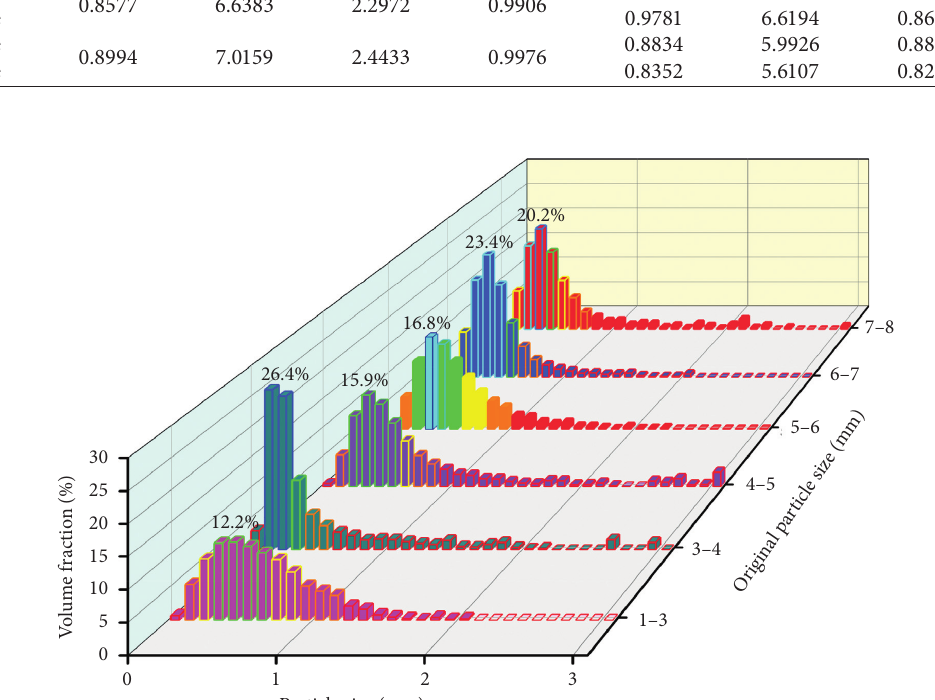
Figure 11: The distribution of particle size after the tests of single particle coal sample. The volume fraction represents Feret’s minimum diameter volume